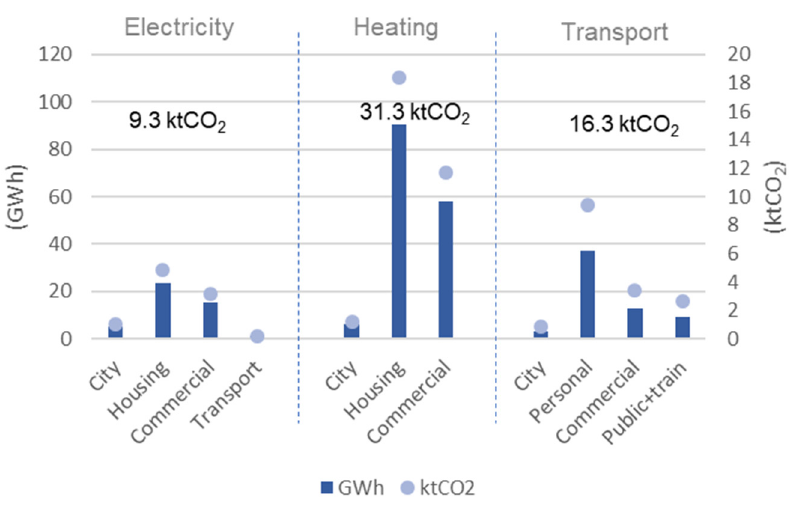
Figure 7. The city’s annual CO 2 emissions.